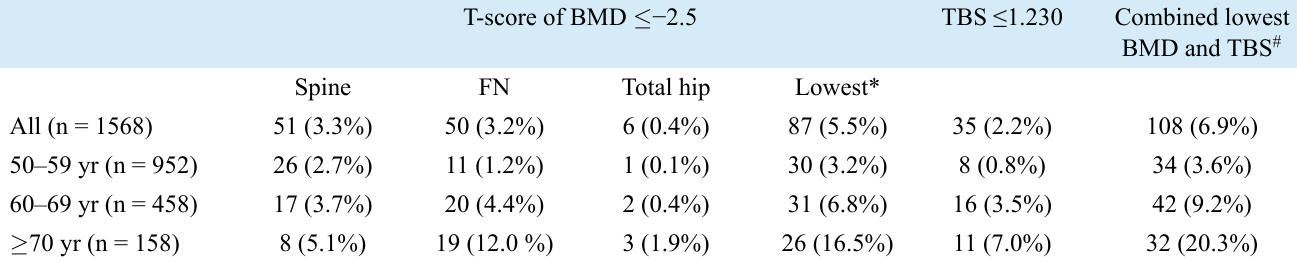
TABLE 2. Numbers of patients at high risk of fracture in different age groups, as determined by combining BMD